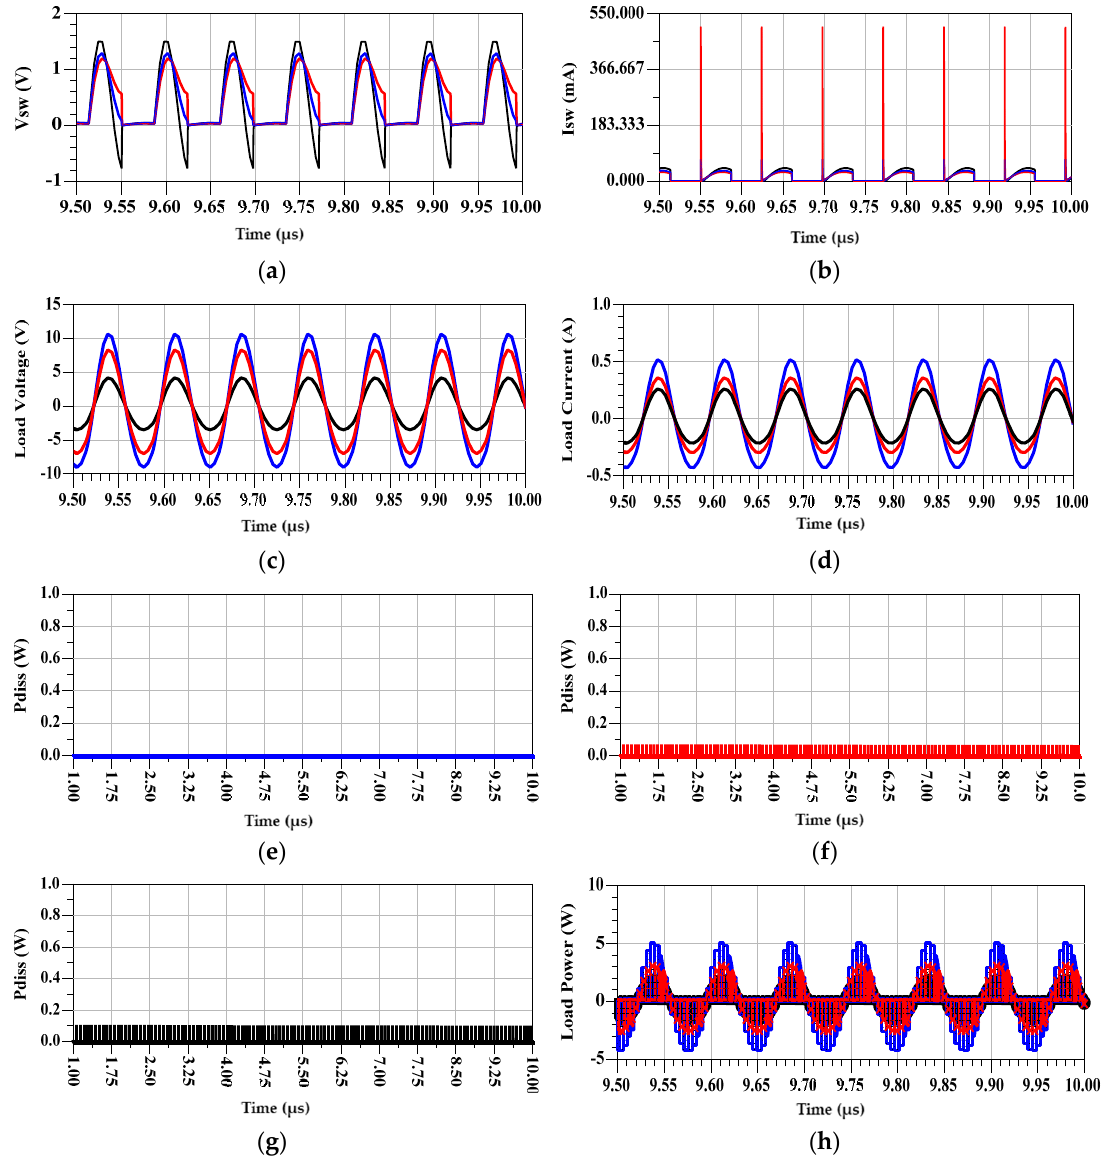
Figure 10. PA load variation (blue line) R L = 13.5 Ω , (red line) R L = 16 Ω , (black line) R L = 21 Ω : ( a ) V sw ; ( b ) I sw ; ( c ) load voltage; ( d ) load current; ( e ) power dissipation across switch at R L = 13.56 Ω ; ( f ) power dissipation across switch at R L = 16 Ω ; ( g ) power dissipation across switch at R L = 21 Ω ; and ( h ) load power.